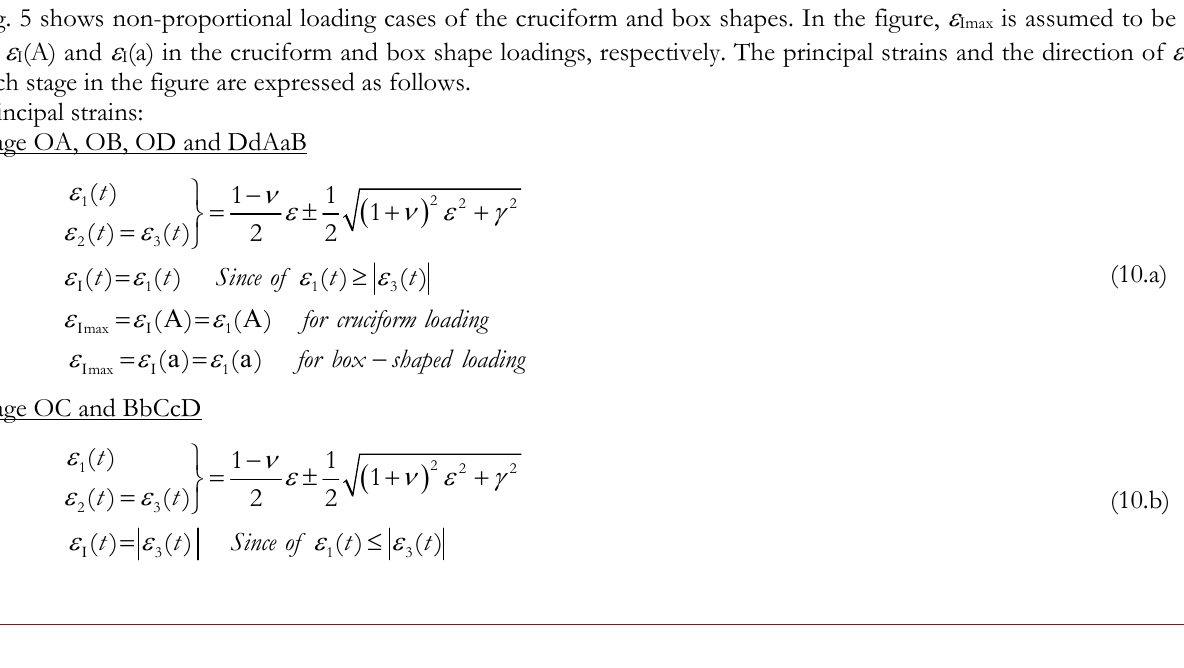
Non-proportional